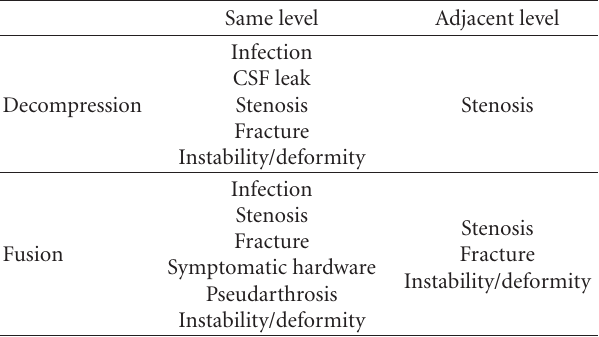
Table 1: The di ff erential diagnosis of the revision spine